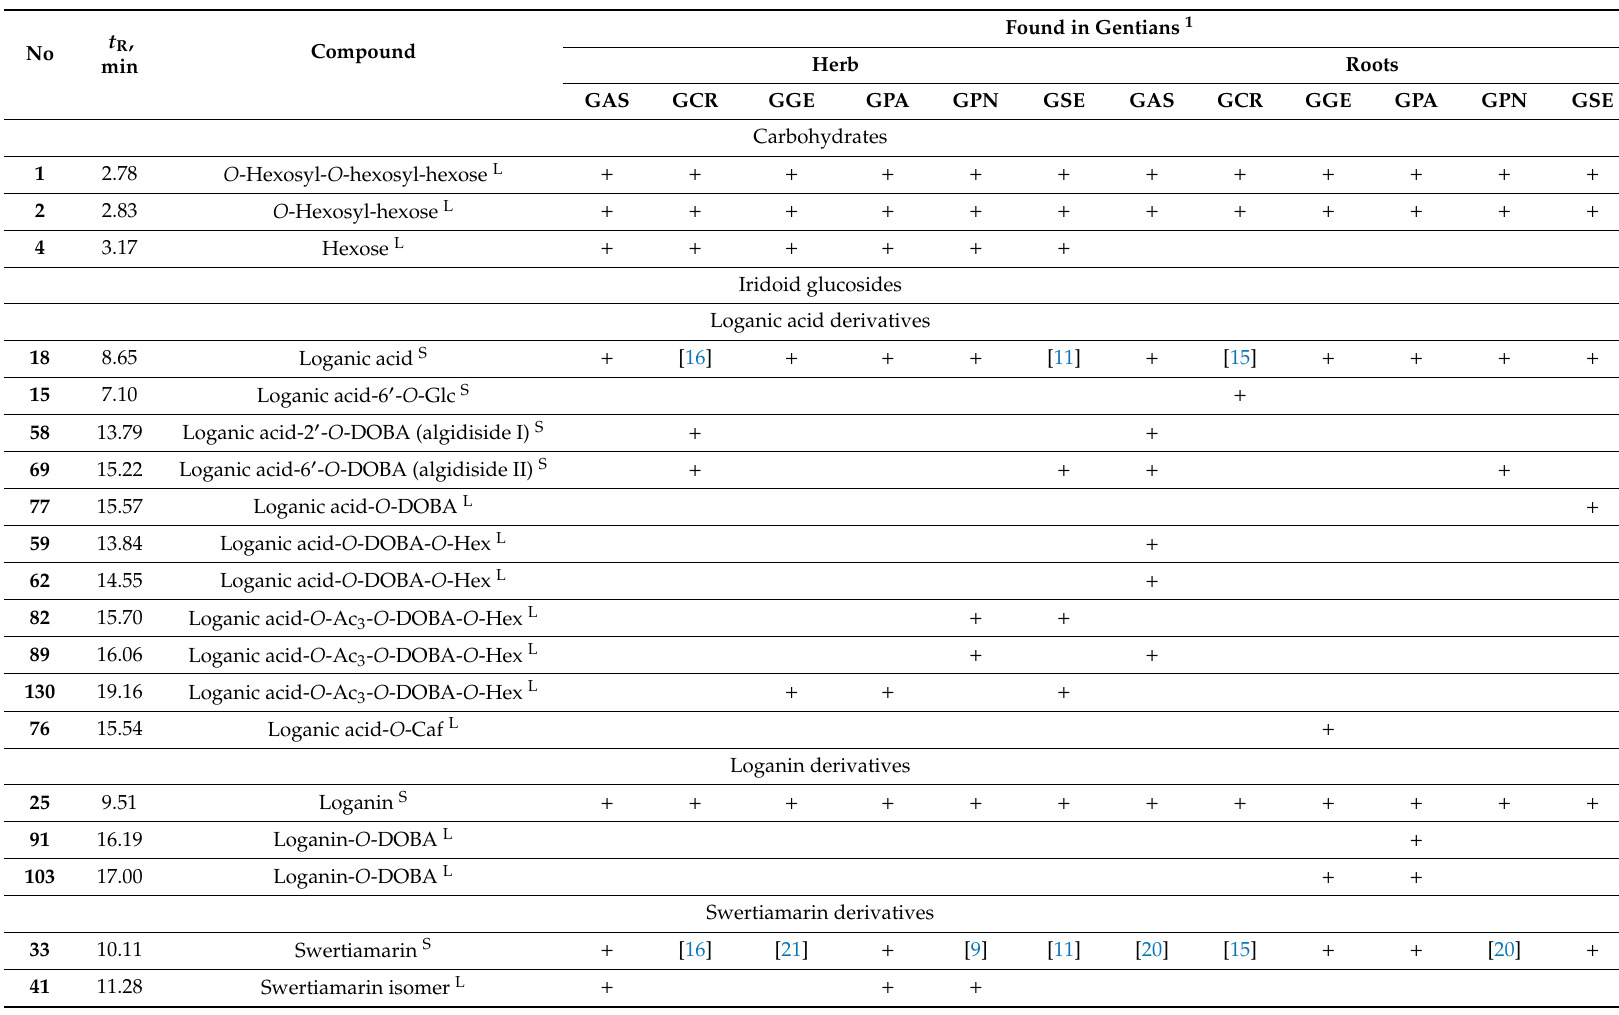
Table 1. Compounds 1 – 137 found in the herb and roots of six Caucasian Gentiana